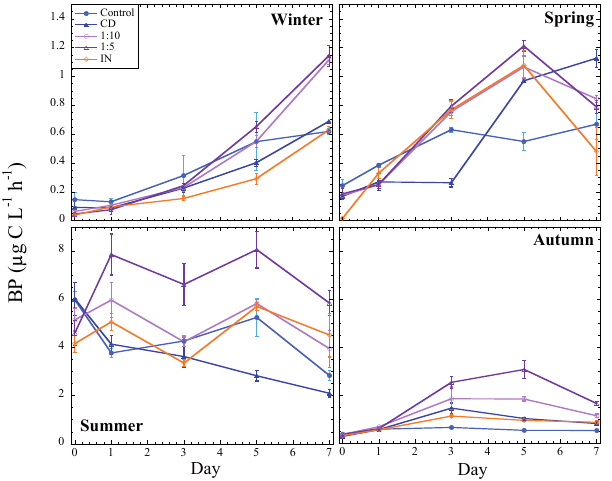
Figure 6. Bacterial production in µgCL − 1 h − 1 for the different measured days for the different treatments and